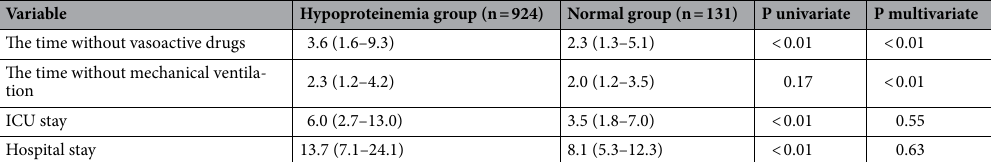
Table 3. The effect of the lowest in-hospital albumin level on the clinical outcome of 1055 patients. In multivariate regression analysis, the influences of factors (such as SAPSII score, septic shock, chronic kidney disease, diabetes, hemoglobin, platelets, serum albumin, the lowest in-hospital albumin level, albumin supplementation, use of vasoactive drugs, and mechanical ventilation) were excluded.